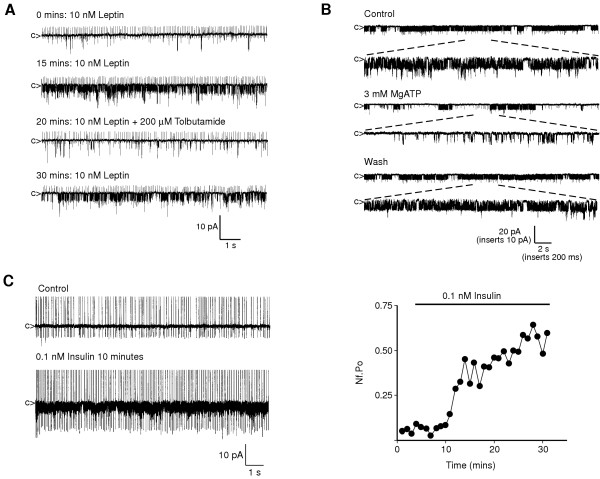
Leptin and insulin activate large conductance KATP in ARC neurones A, representative cell-attached recording from an acutely dissociated ARC neurone. Leptin (10 nM), present in the electrode solution, increased the activity of a K+ channel, which was inhibited reversibly by bath application of 200 μM tolbutamide. Upward deflections in this and subsequent cell-attached recordings are extracellularly recorded action current activity. B, representative recording from an inside-out patch under asymmetrical K+ conditions and held at 0 mV obtained from an acutely dispersed ARC neurone, following cell-attached leptin-induced increase in channel activity. Note that bath application of 3 mM MgATP reversibly inhibited K+ channel activity. Inserts are expanded regions of traces showing channel activity in more detail. C, representative cell-attached recording from an acutely dissociated ARC neurone. Under control conditions, few channel openings are observed. Subsequent to bath application of 0.1 nM insulin, there is a marked increase in KATP channel activity. Corresponding diary plot of channel activity (Nf.Po) with time displays the insulin induced increase in activity.